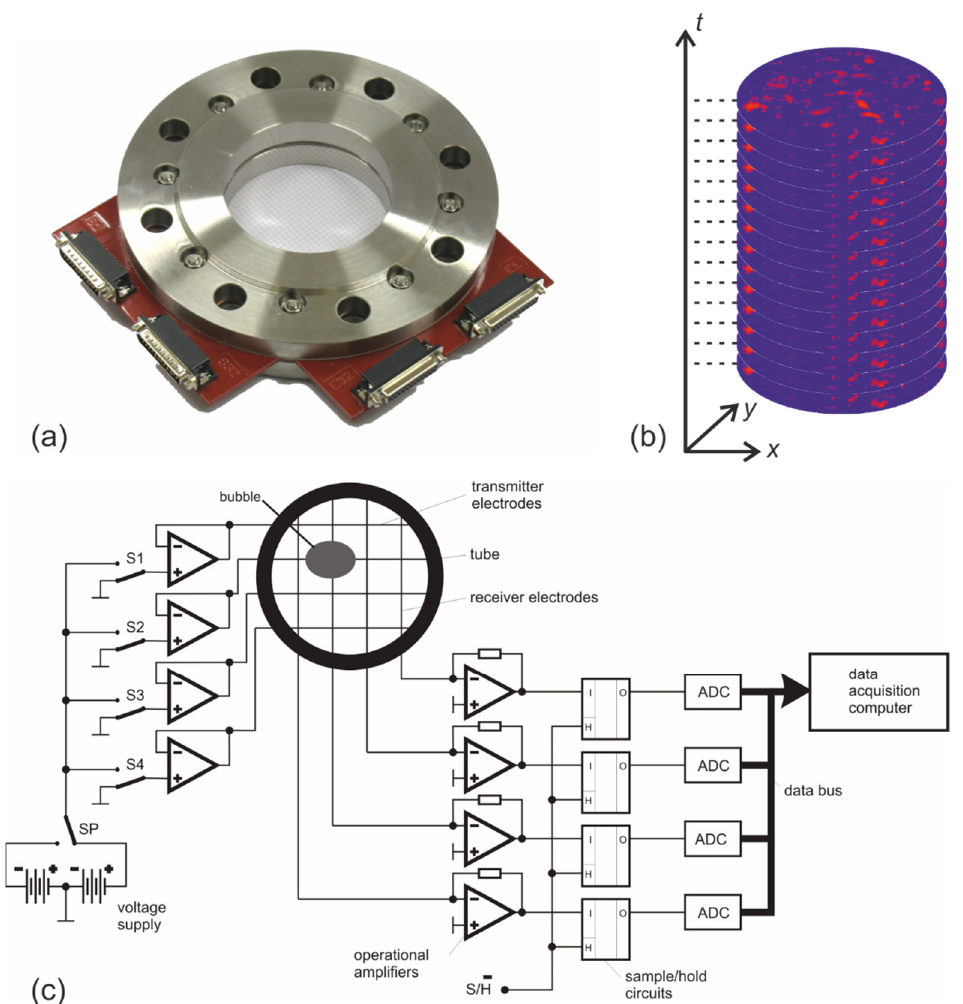
Figure 3. Wire-mesh sensor: ( a ) photography, ( b ) example of a 2D image sequence from a gas-liquid flow (gas phase in red color) obtained with a 2 × 64 wire-mesh sensor, ( c ) electronics scheme.